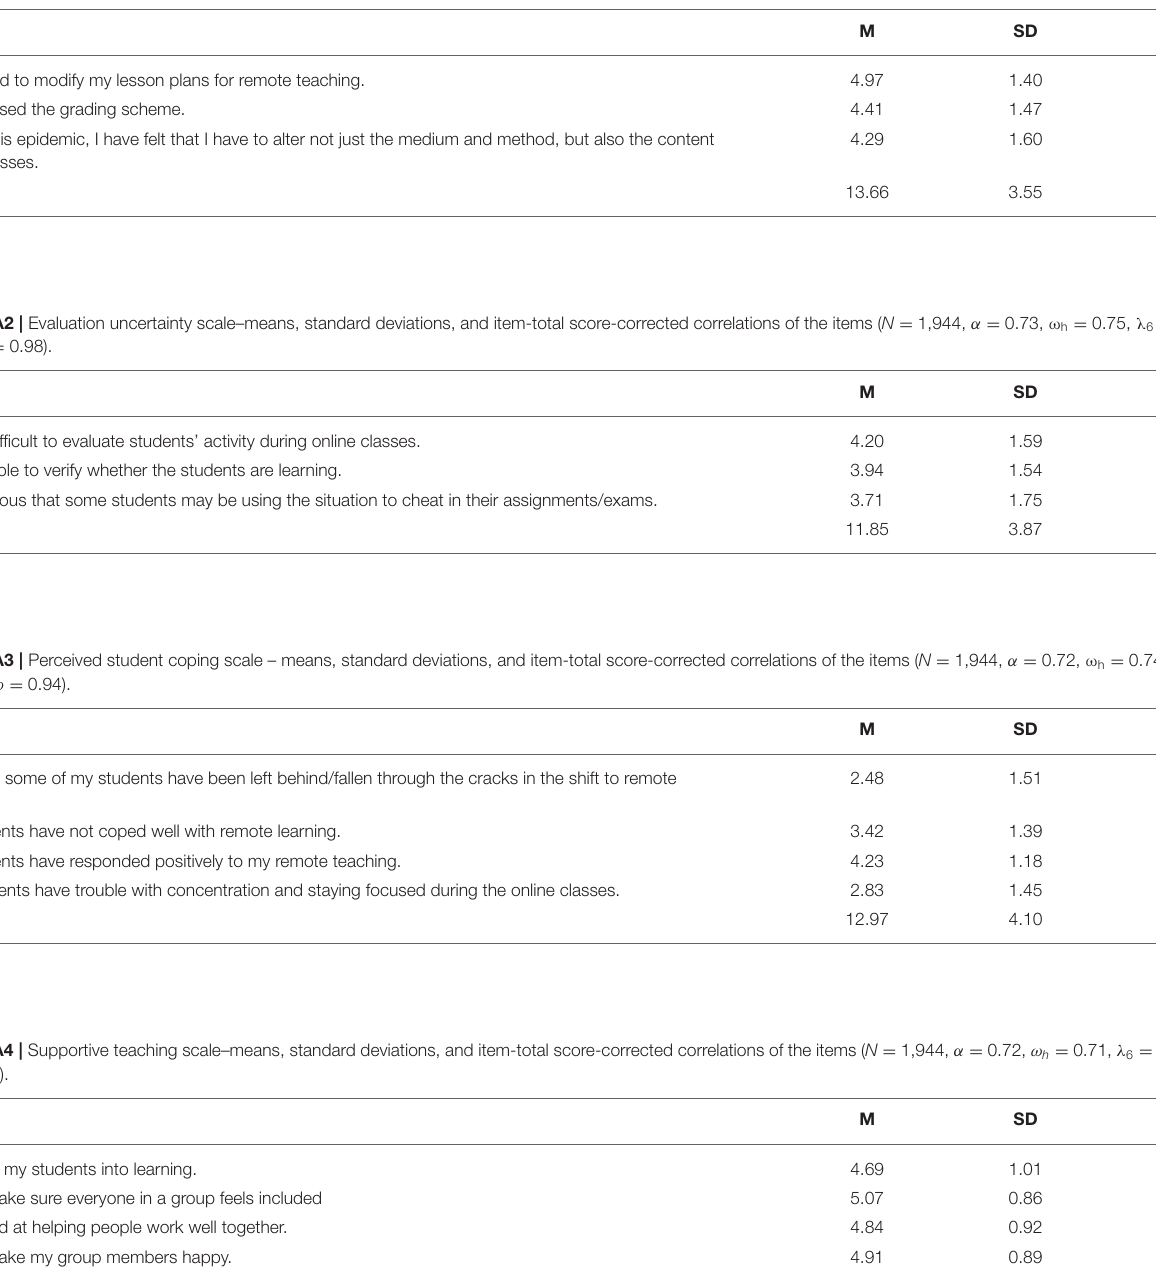
TABLE A1 | Instructional adjustment scale–means, standard deviations, and item-total score-corrected correlations of the items ( N = 1, 944, α = .70, ω h = 0.68, λ 6 = 0.59, ρ = .98). Items M SD r tt